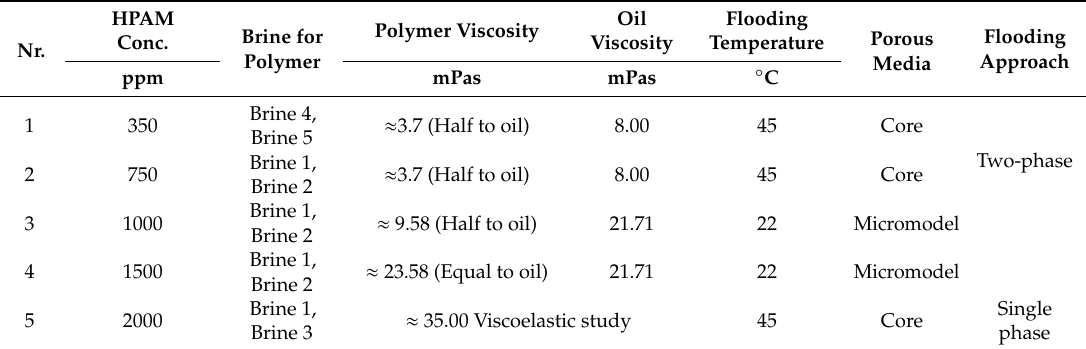
Table 4. Polymer steady shear viscosity at a shear rate of 10 s − 1.